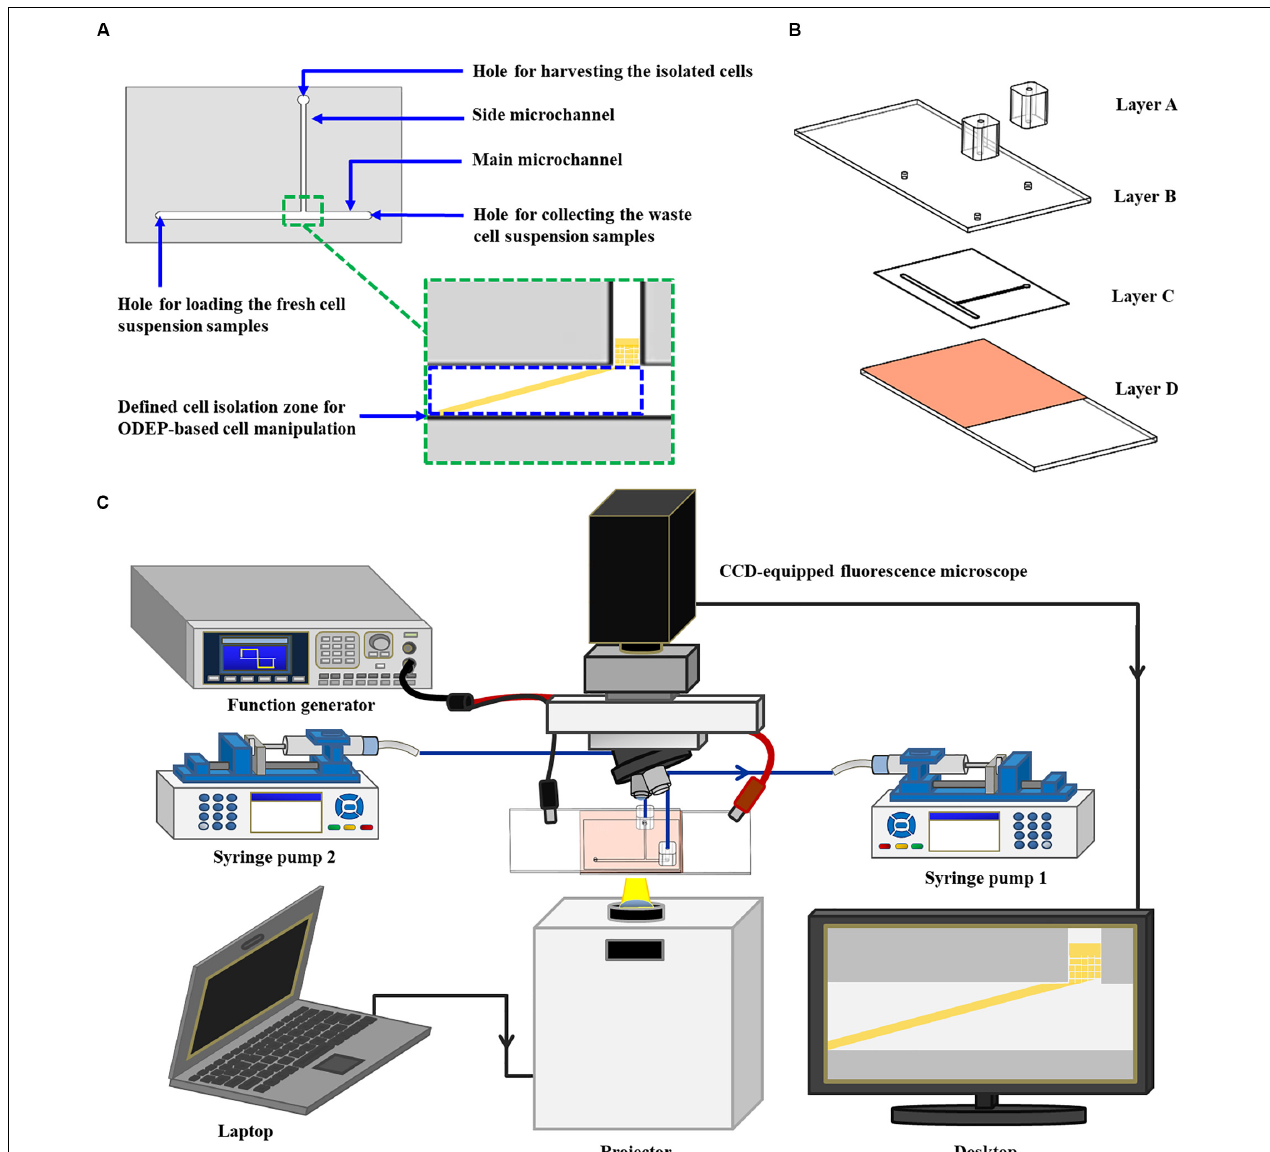
FIGURE 1 | Schematic presentation of the (A) top-view design layout and (B) the structure of an ODEP microfluidic chip (Layer A: two PDMS adapters for tubing connection; Layer B: an ITO glass; Layer C: a double-sided adhesive tape with a hollow T-shaped microchannel; Layer D: an ITO glass coated with a photoconductive layer), and the (C) the whole operating